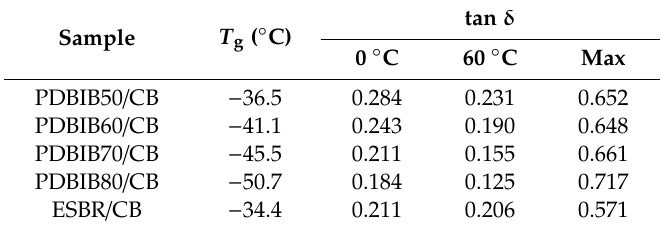
Table 9. Dynamic mechanical thermal analysis of PDBIB/silica nanocomposites.